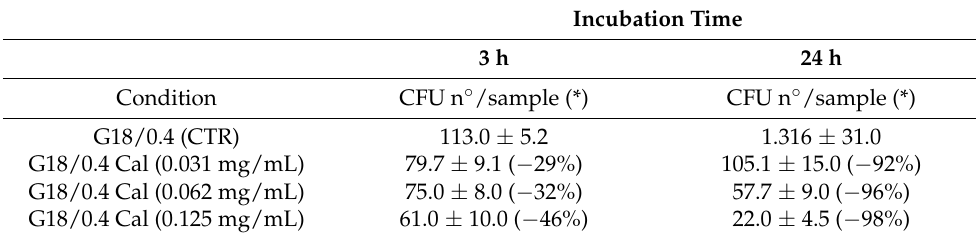
Table 5. Antifungal activity of the indicated